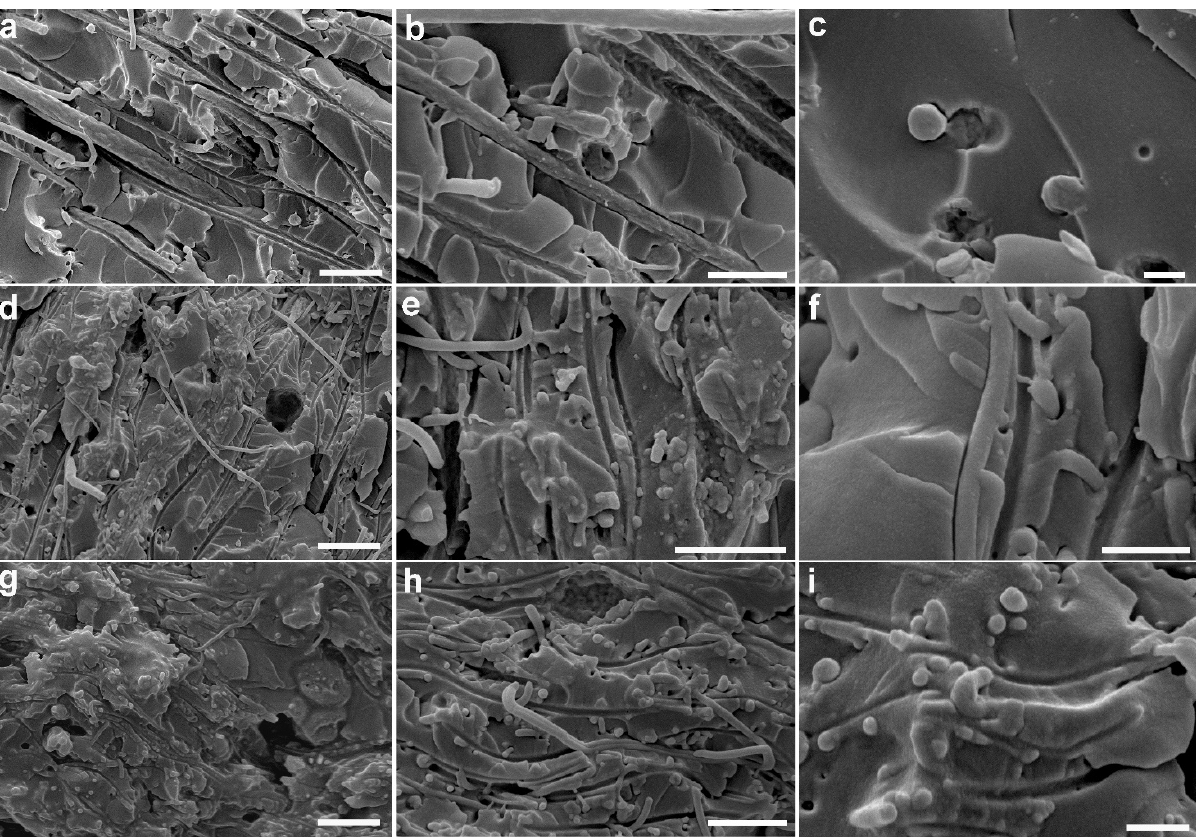
Figure 5. SEM images of electrospun fibres/epoxy matrix composites (cross-sections obtained by brittle fracturing in liquid nitrogen) after curing: ( a – c ) PVDF, ( d – f ) PVDF/PCADE 85/15 and ( g – i ) PVDF/PCADE 70/30. Scale bar = 10 μm (a,d,g); 5 μm (b,e,h); 2 μm (c,f,i).